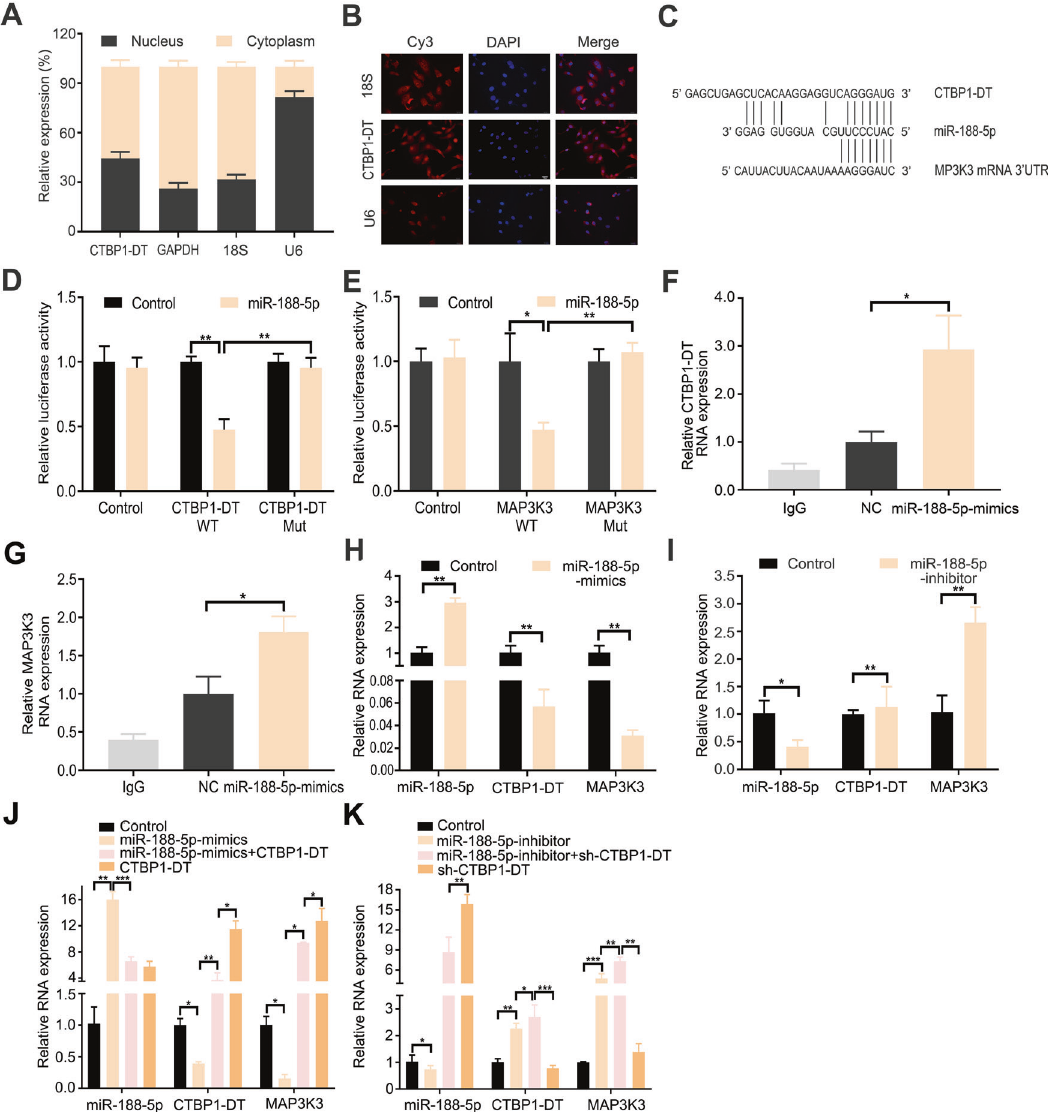
Fig. 4 LncRNA CTBP1-DT acts as a miRNA sponge of miR-188-5p to regulate MAP3K3 expression in HGSOC cells. A qRT-PCR analysis for lncRNA CTBP1-DT expression and GAPDH, U6, 18S. The nuclear and cytoplasmic fractions of HEK 293T cells were located, followed by qRT-PCR assays. U6, 18S and GAPDH acted as negative controls. B The cellular location of lncRNA CTBP1-DT in cells by FISH assay (scale bar, 100 μ m). C Schematic diagram representing the predicted binding sites for miR-188-5p, lncRNA CTBP1-DT and MAP3K3. D , E Fire fl y luciferase activity normalised to luciferase activity in HEK 293T cells co-transfected with luciferase reporters with wild-type or mutant transcripts of lncRNA CTBP1-DT or MAP3K3 along with miR-188-5p mimics or negative control. F , G RIP and RT-PCR were performed in HEK 293T cells to measure the lncRNA CTBP1-DT or MAP3K3 expression associated with miR-188-5p mimic. H , I miR-188-5p mimic overexpression resulted in decreased expression of lncRNA CTBP1-DT and MAP3K3, and miR-188-5p inhibitor overexpression upregulated lncRNA CTBP1-DT and MAP3K3 expression. J mRNA expression of lncRNA CTBP1-DT and MAP3K3 was determined by analysis after co-transfection with miR-188-5p mimic and lncRNA CTBP1-DT. K mRNA expression of lncRNA CTBP1-DT and MAP3K3 was determined by analysis after co-transfection with miR-188- 5p inhibitor and sh-lncRNA CTBP1-DT. Data are presented as the mean ± SEM. * P < 0.05, ** P < 0.01, *** P < (Fig. 5A). We designed shRNAs targeting ETV5. Expression of lncRNA CTBP1-DT was measured following ETV5 knockdown or overexpression. The results revealed that ETV5 knockdown led to a signi fi cant decrease in the expression of lncRNA CTBP1-DT in SKOV3 and A2780 cells. Moreover, ETV5 overexpression enhanced the expression of lncRNA CTBP1-DT in OV2008 cells. The expression of MAP3K3 corresponded with that of lncRNA CTBP1- DT (Fig. 5B – D). Consistent with these results, we found that the knockdown of ETV5-2 decreased the expression of lncRNA CTBP1- DT and MAP3K3 in SKOV3 and A2780 cells. However, these effects were reversed by overexpression of lncRNA CTBP1-DT.